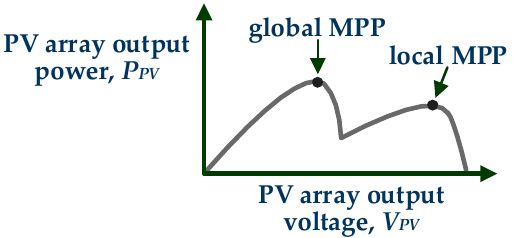
Figure 1. An example of the power-voltage characteristic of a photovoltaic (PV) array under partial shading conditions.